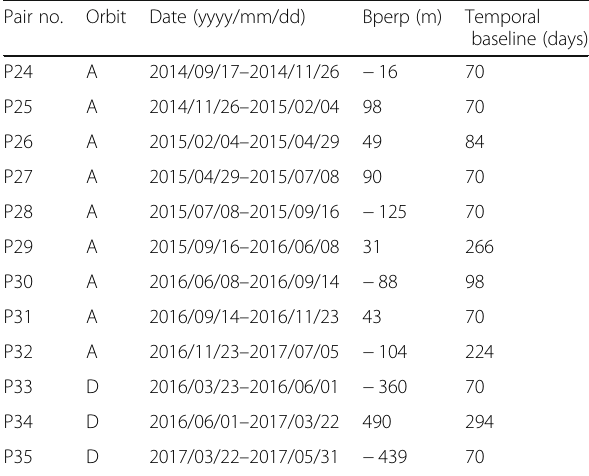
Table 2 ALOS-2/PALSAR-2 data sets for interferograms in Fig. 4. The A and D stand for ascending and descending (mostly from the north to the south) orbits. The path and frame of the ascending and descending datasets are 176 – 800 and 71 – 2800, respectively. The incidence angle of the ascending and descending datasets are 31.4° and 36.3°, respectively. Heading angles of ascending and descending datasets are − 10.8 and − 169.8°,